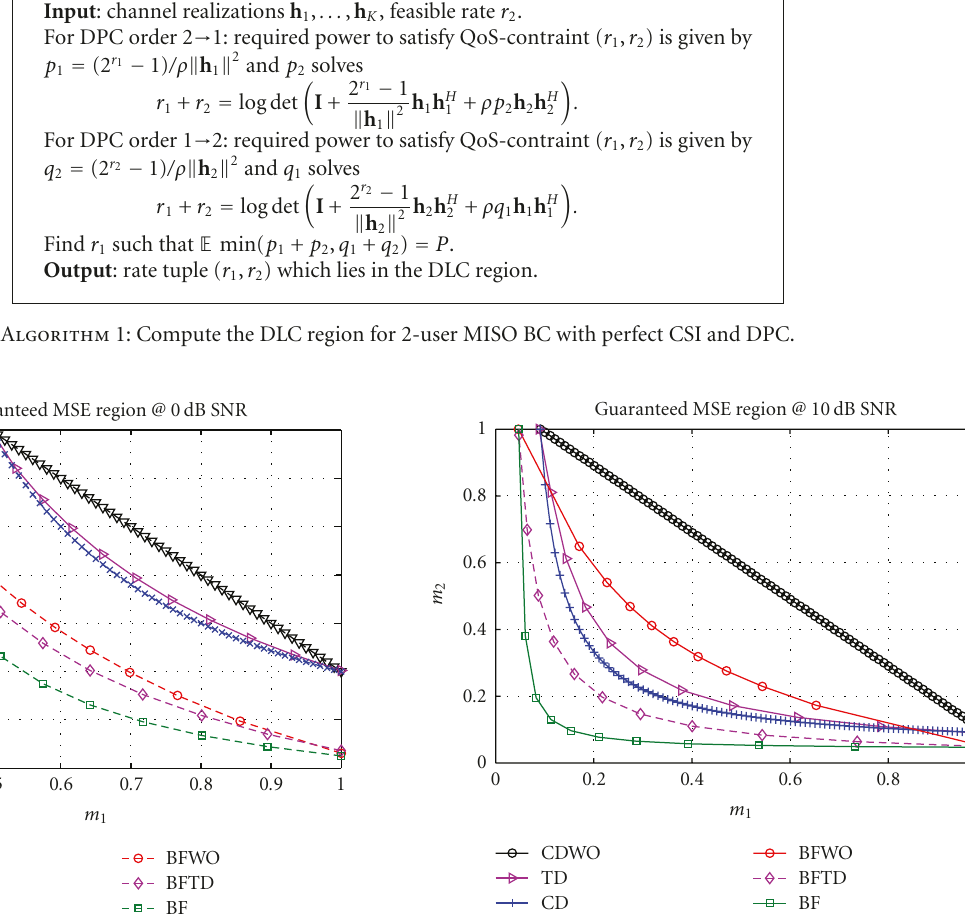
Figure 4: Guaranteed MSE region with and without superposition coding and with full collisions compared to perfect CSI and nonlinear and linear precoding with and without time-sharing for SNR 0 dB.